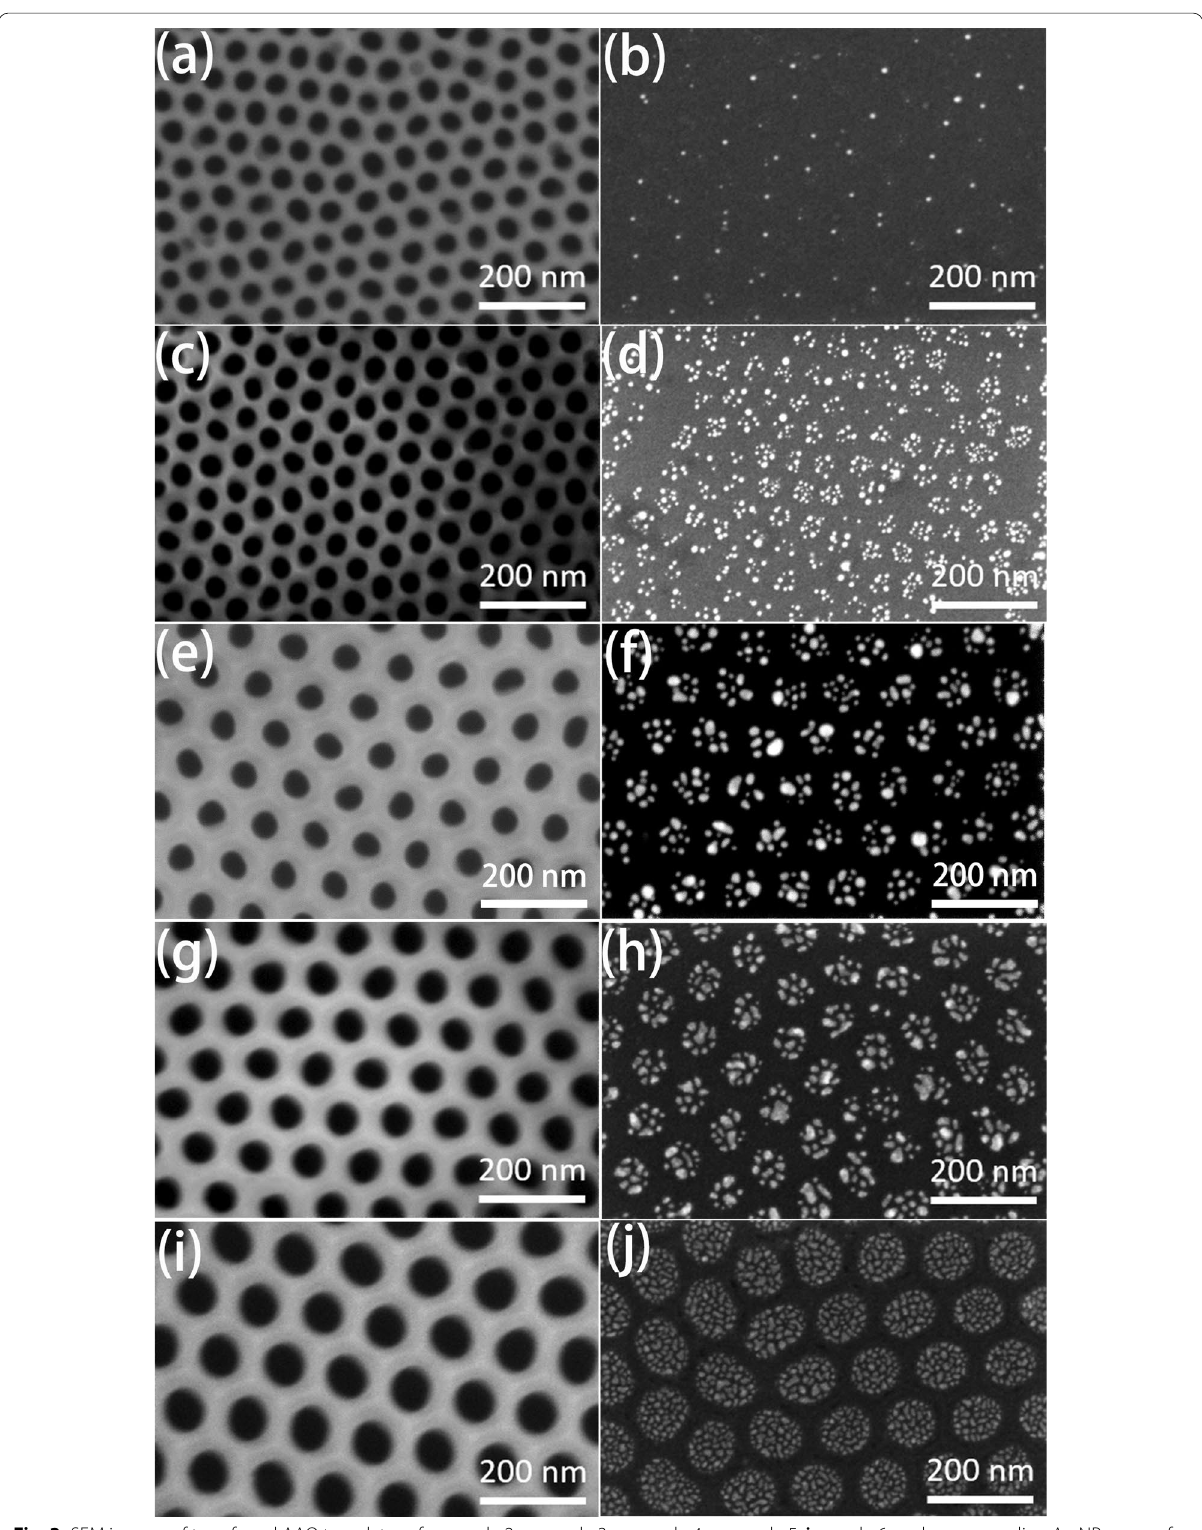
Fig. 3 SEM images of transferred AAO templates of a sample 2, c sample 3, e sample 4, g sample 5, i sample 6, and corresponding Ag NP arrays of b sample 2, d sample 3, f sample 4, h sample 5, j sample